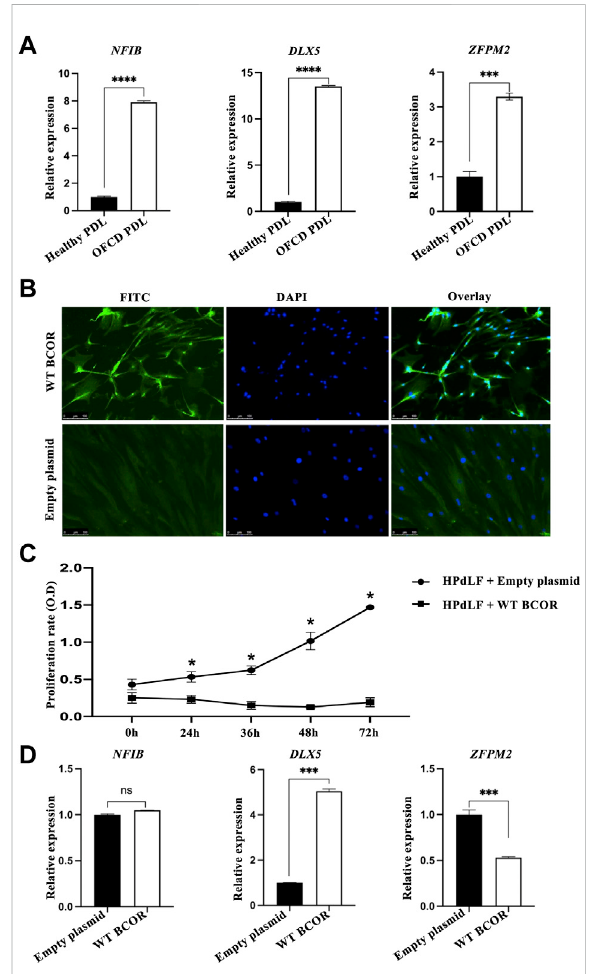
FIGURE 1 Microarray gene pro fi lingand invitro assay of HPdLF cells. (A) qRT-PCR validation of microarray analysis for upregulating genes with a fold change greater than 15. Expression levels of ZFPM2 , NFIB , and DLX5 relative to GAPDH expression were determined. Data are expressed as the means ± standard deviations; t -test,**** p < 0.0001,*** p < 0.001. (B) Overexpression of WT BCOR in HPdLF cells in vitro. HPdLF cells stably